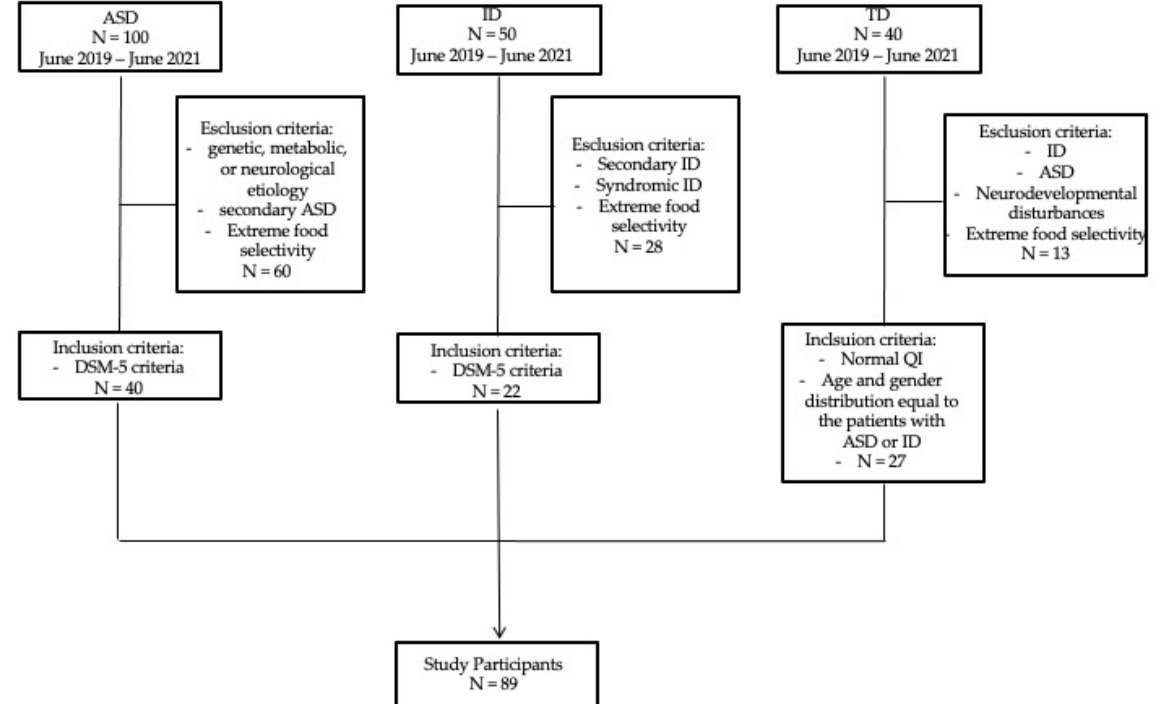
Figure 1. Recruitment Flow Diagram. ASD = Autism Spectrum Disorder; ID = Intellectual Disability; TD = Typical Development.